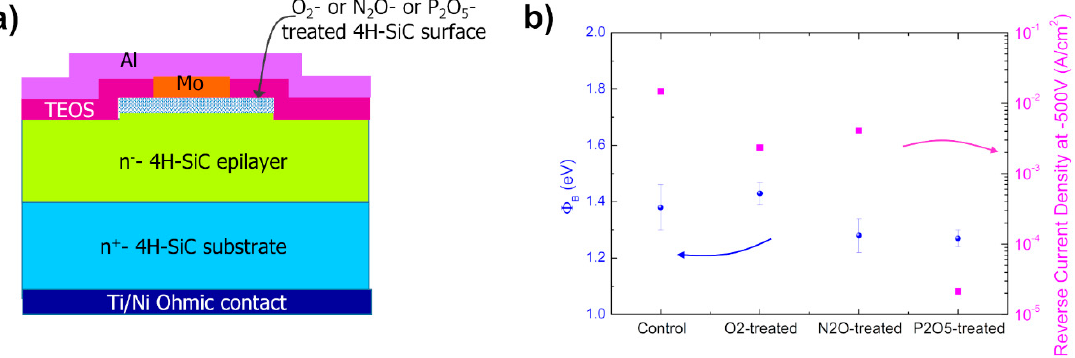
Figure 8. ( a ) Schematic view of Mo/4H-SiC Schottky diodes with premetallization treatments of the semiconductor surface, consisting of thermally grown oxidation in O 2 and N 2 O or oxide deposition of P 2 O 5 , followed by oxide removal prior to Mo deposition in all cases. ( b ) Schottky barrier height and reverse leakage current density at − 500V values averaged over a set of I – V F curves of equivalent Mo/4H-SiC Schottky diodes with 4H-SiC surface pretreated under different conditions. Panel ( b ) is adapted with permission from Ref. [63]). Copyright 2021 AIP Publishing.